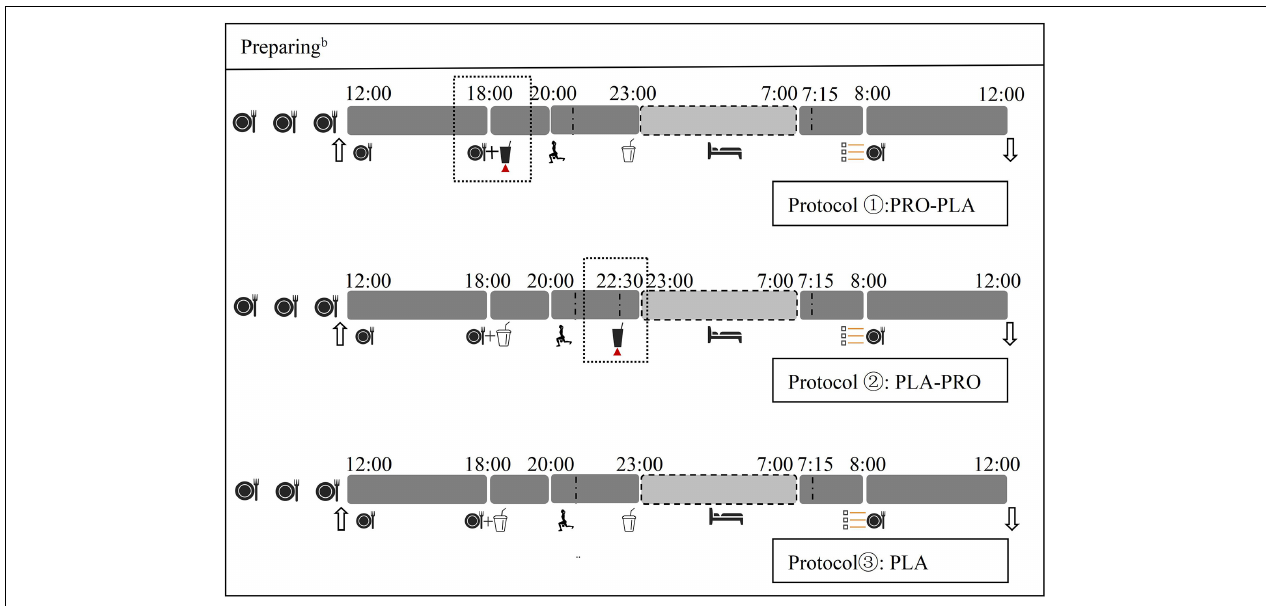
FIGURE 2 | Study protocol for the experimental conditions. b The day before experiment; Standard meal Enter the HC chamber Out of the HC chamber Resistant exercise Protein supplementation Visual analog scale (VAS) test Sleep